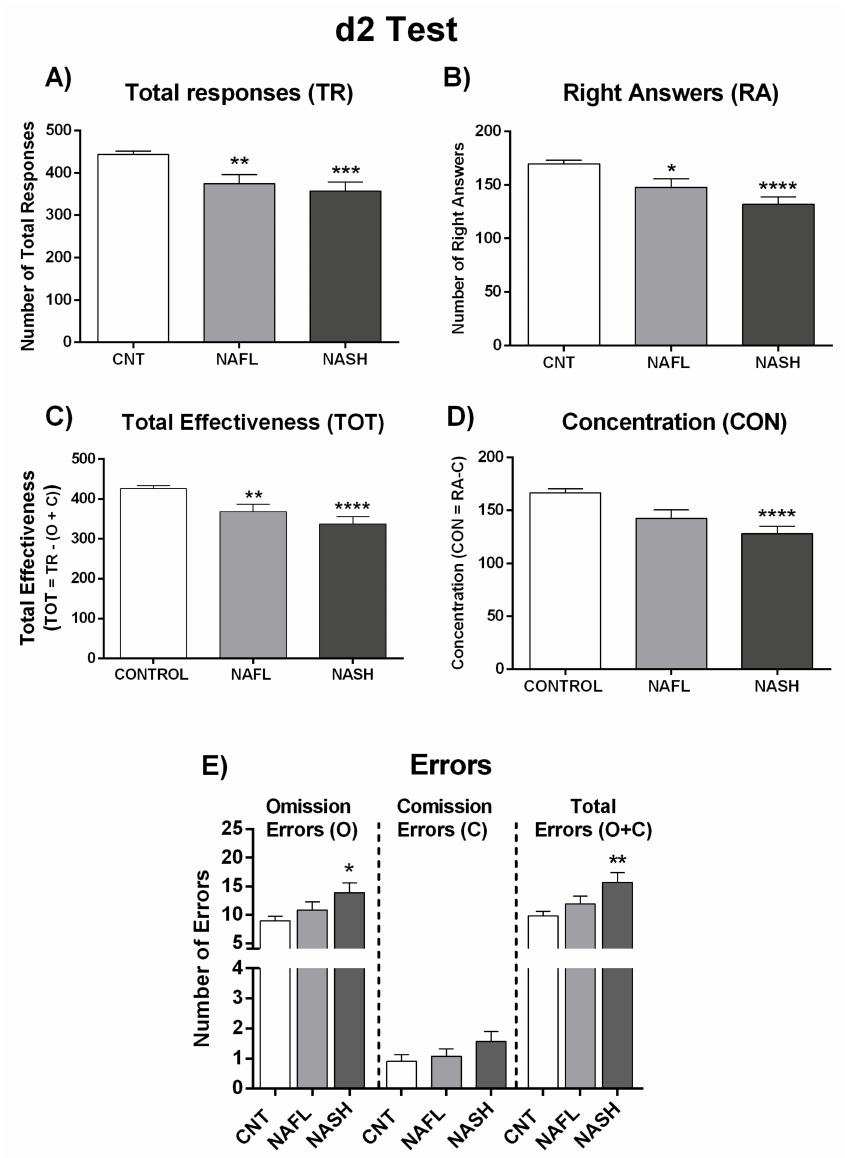
Figure 2. Performance of NAFL and NASH patients in d2 test. ( A ) Number of total re- sponses (TR), ( B ) right answers (RA), and ( C ) total effectiveness (TOT), which was calculated by: TOT= TR − (O + C). ( D ) Concentration index (CON), which was calculated by: CON = RA − C. ( E ) Number of errors by Omission (O), Comission (C), and total errors (O + C). Results are the mean ± SEM. * p < 0.05; ** p < 0.01; *** p < 0.001; **** p < 0.0001 vs. control group (CNT). NAFL, NASH, patients with nonalcoholic fatty liver and nonalcoholic steatohepatitis,